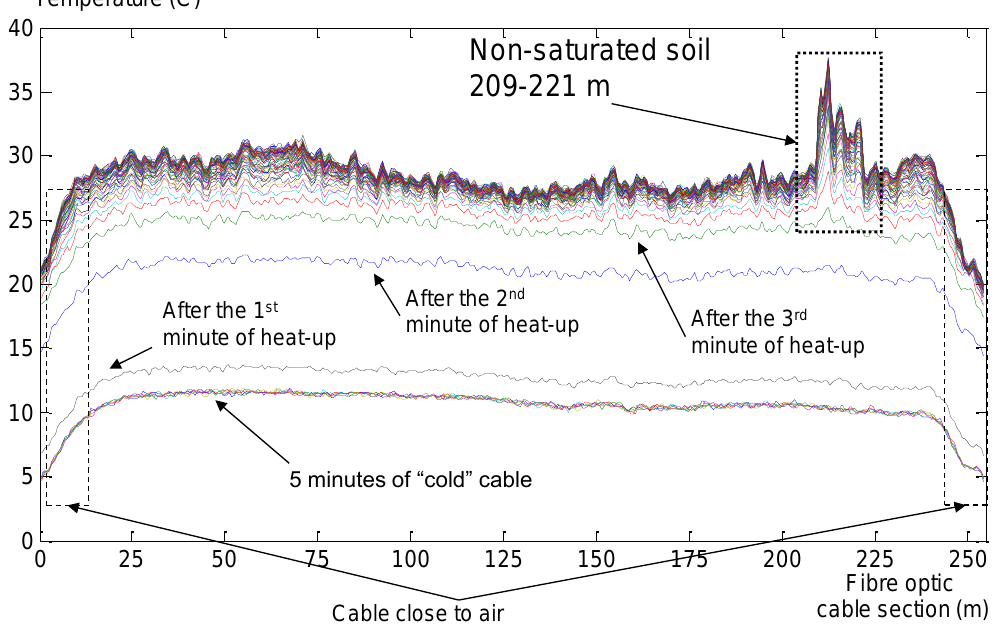
Figure 14. Rhine levee GTC Kappelmeyer fibre optic cable heat-up in time: X axis—length of the cable (m), Y axis—temperature (Celsius). The colours indicate different